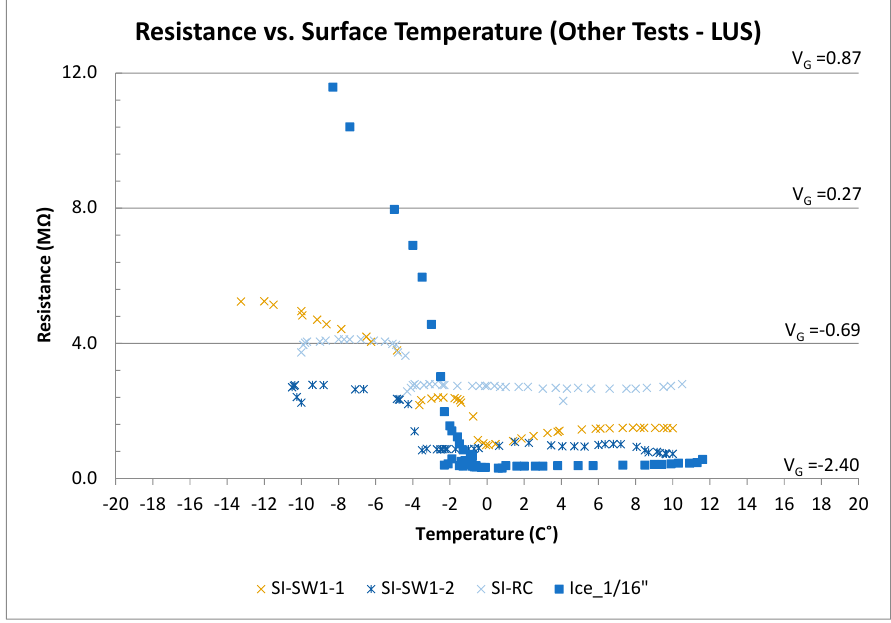
Figure 14. Resistance (and voltage) versus surface temperature for other tests (LUS Poles).